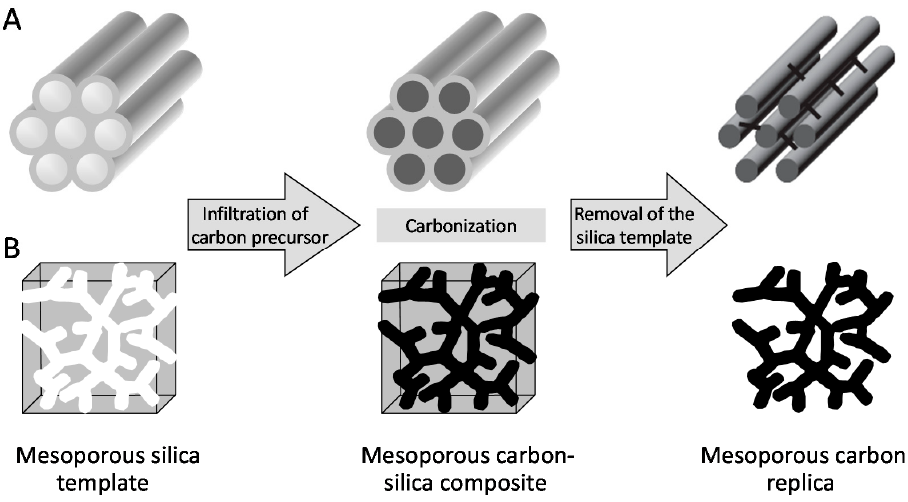
Figure 1. Illustration of the hard template casting route to OMC: ( A ) Hexagonal CMK-3; ( B ) Cubic CMK-1.